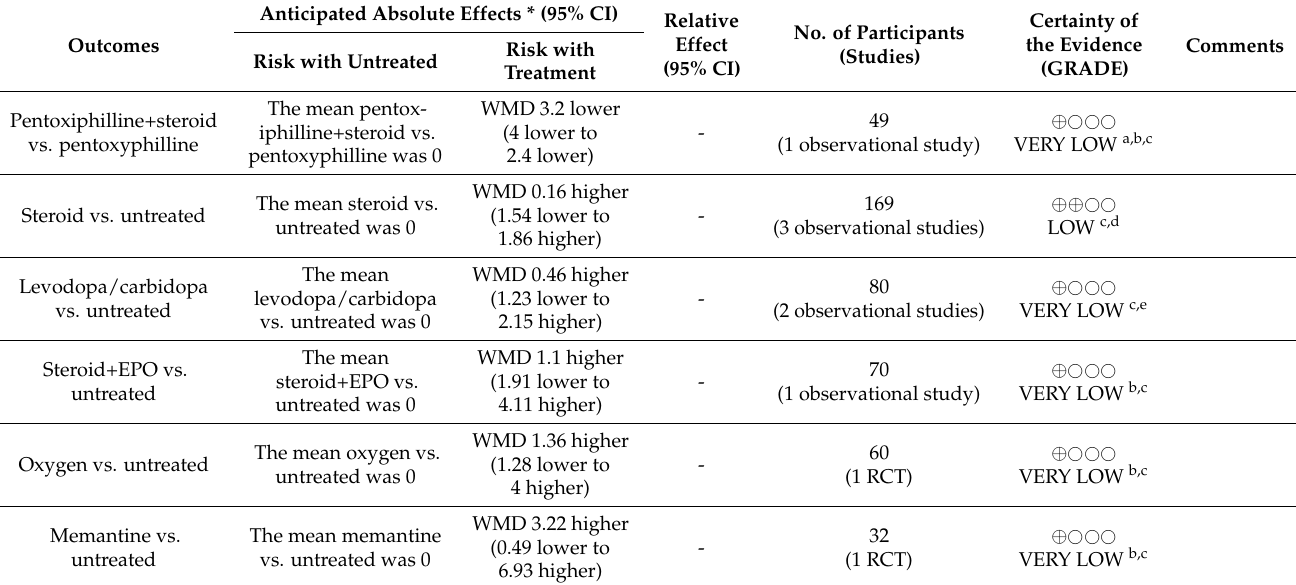
Table 5. GRADE of evidence of our results for visual